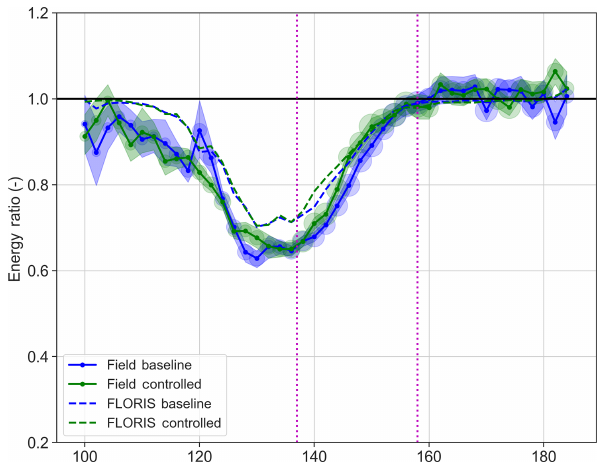
Figure 15. Combined change in energy ratio for T3 and